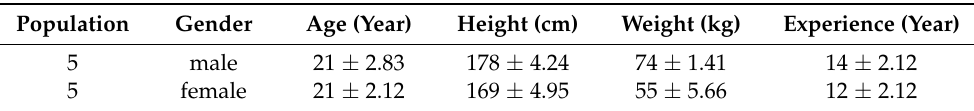
Table 1. The participant information (mean ± SD).